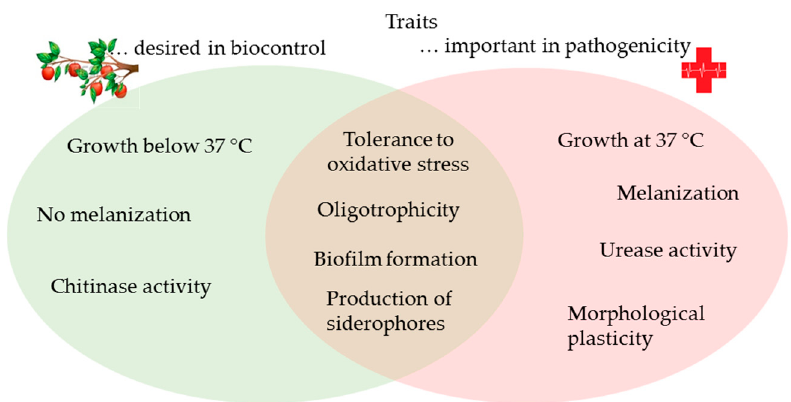
Figure 6. Overlap between the traits involved in pathogenesis and that are desirable for antagonism in biocontrol.